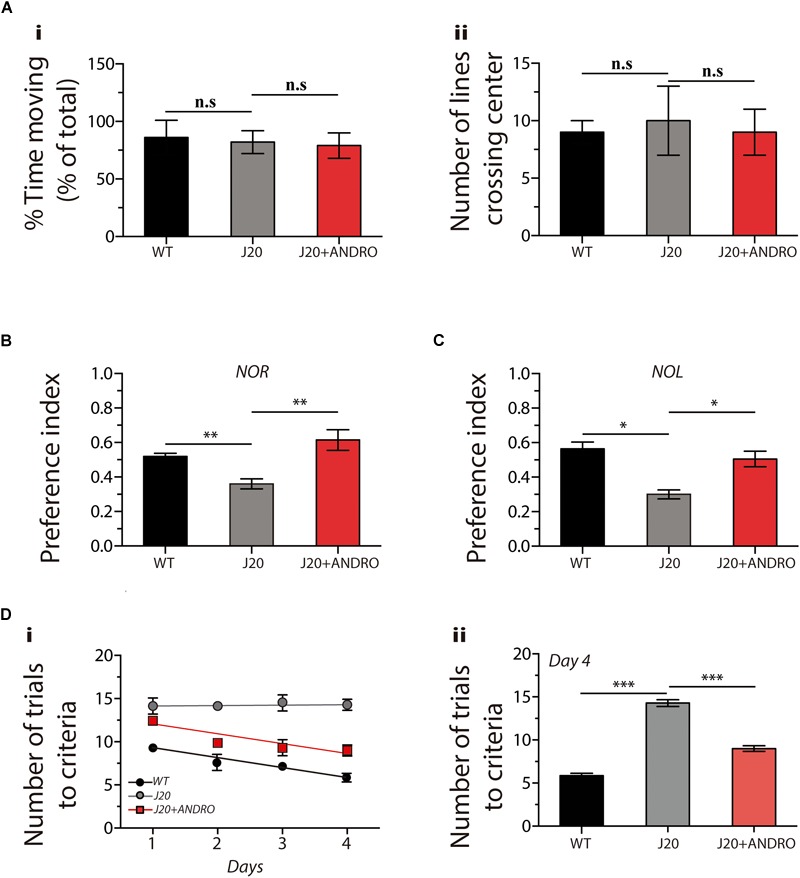
The administration of ANDRO improves cognitive performance in a transgenic model of AD. After the indicates treatments, cognitve test related to hippocampal function were performed: large open field (A), NOR (B), NOL (C) and memory flexibility (D). Data represent the mean ± SEM of n = 9 (number of animals), p ≤ 0.05 (95% CI) was considered the threshold for statistical significance, details in the “Results” Section.